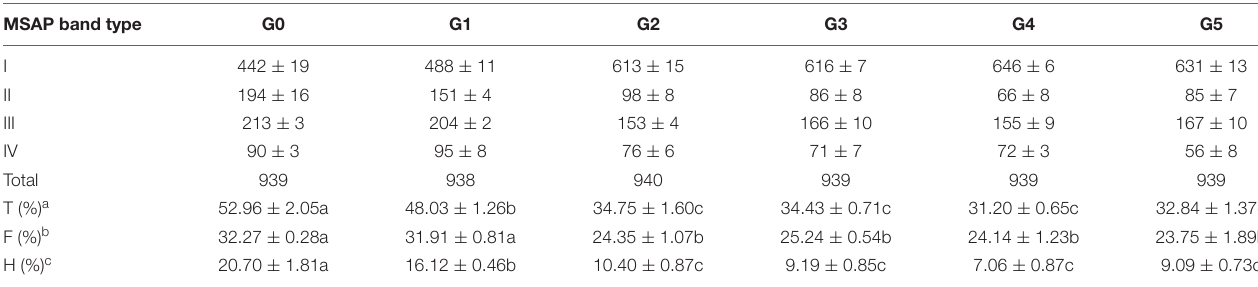
TABLE 1 | Change in P. nigra N46 DNA methylation levels among regenerated plants of five generations compared with those of donor plants. MSAP band type